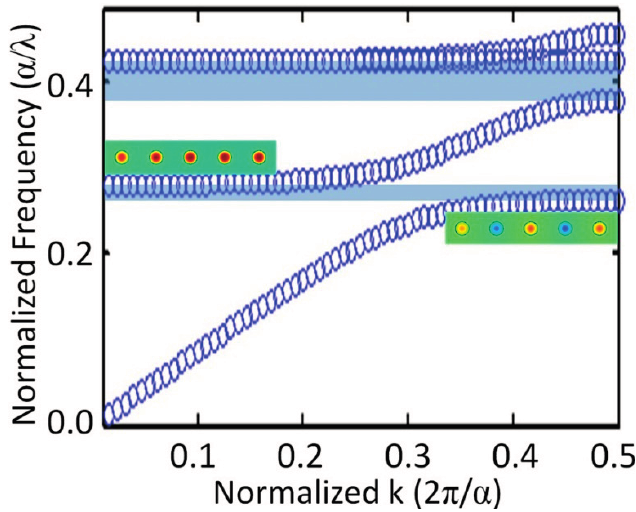
Figure 4. H-field phase patterns in cross-section of rods for 5 PRA array at frequencies: 0.29 (upper row) and 0.312 (lower row).